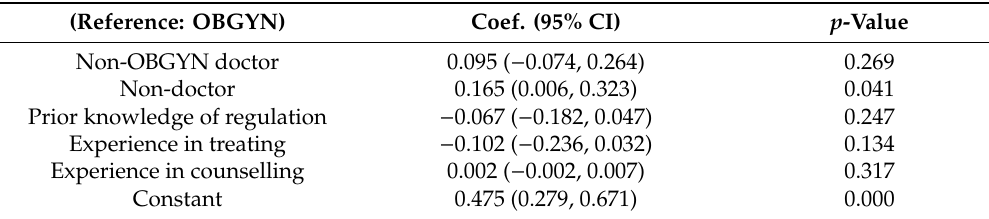
Table 4. Least-squares regression analysis on the attitudes towards adolescents and women experiencing unplanned pregnancies and having undergone unsafe abortions.